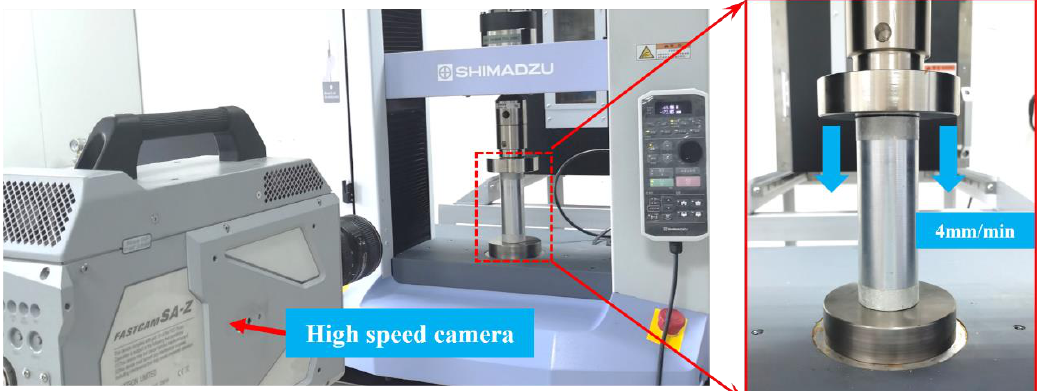
Figure 4. Quasi-static axial crushing test set-up.